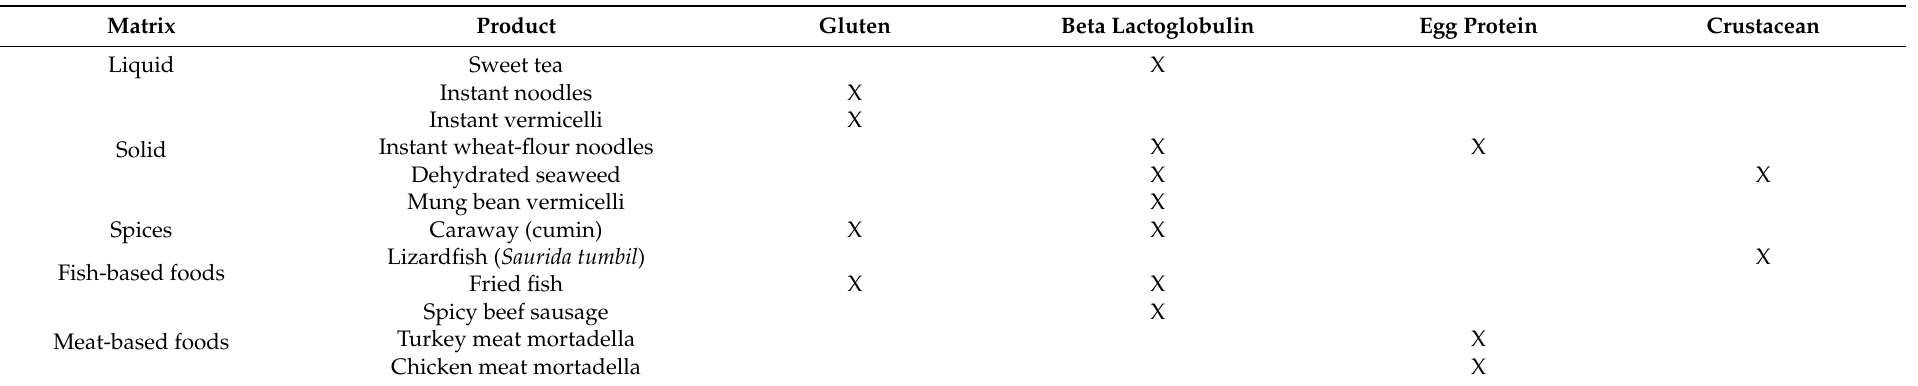
Table 6. Allergens present in food matrices.